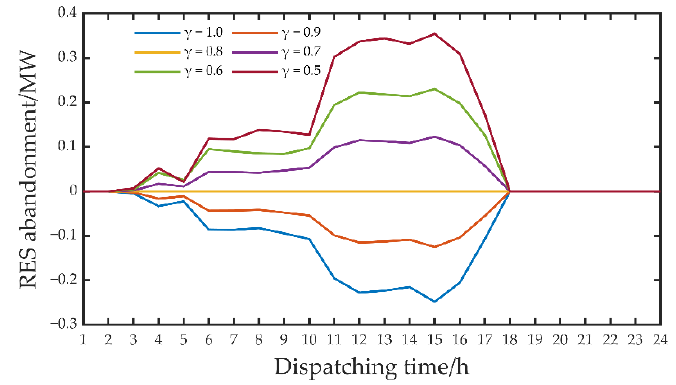
Figure 19. RES abandonment under different mass flow rates.